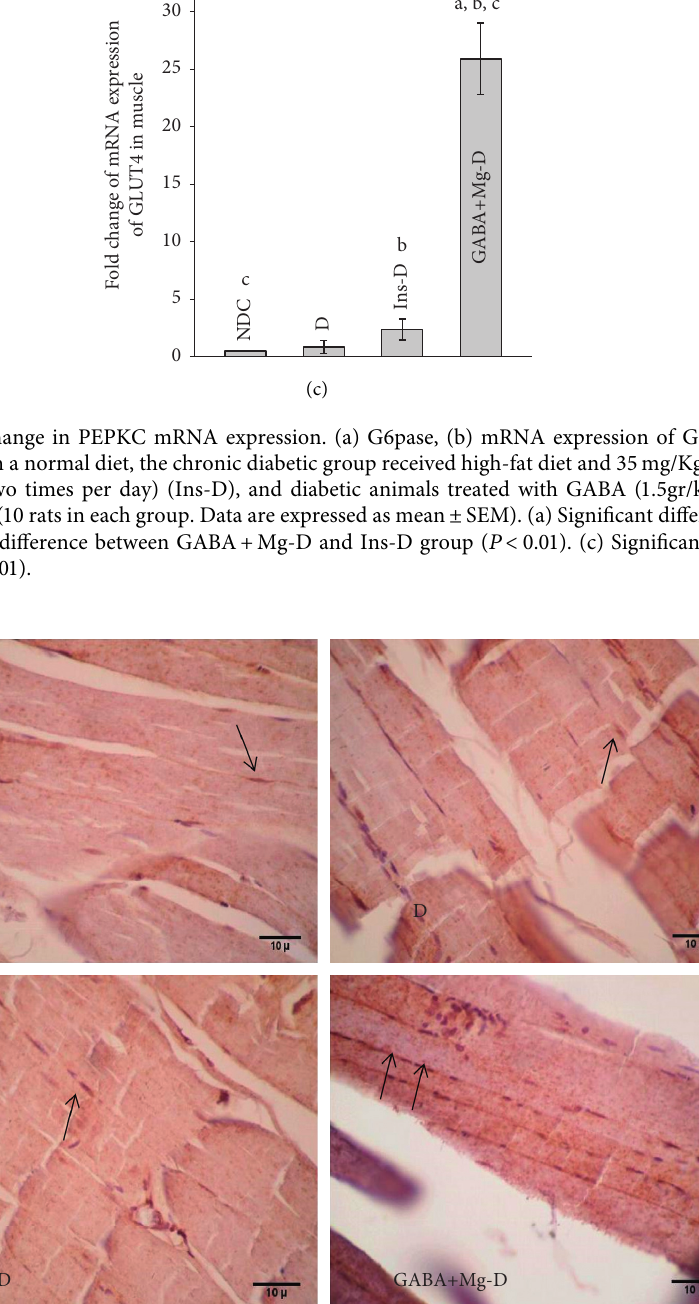
Figure 6: Comparison of immunohistochemistry for GLUT4 in the nondiabetic control group (NDC) fed with a normal diet, the chronic diabetic group received high-fat diet and 35mg/Kg STZ (D), diabetic animals treated with insulin (2.5U/Kg two times per day) (Ins-D), and diabetic animals treated with GABA (1.5gr/kg)+MgSO 4 (10 g/l add in drinking water) (GABA+Mg-D) (10 rats in each group. Data are expressed as mean ± SEM) (X400, black arrows indicate the translocation of GLUT4 to the cell